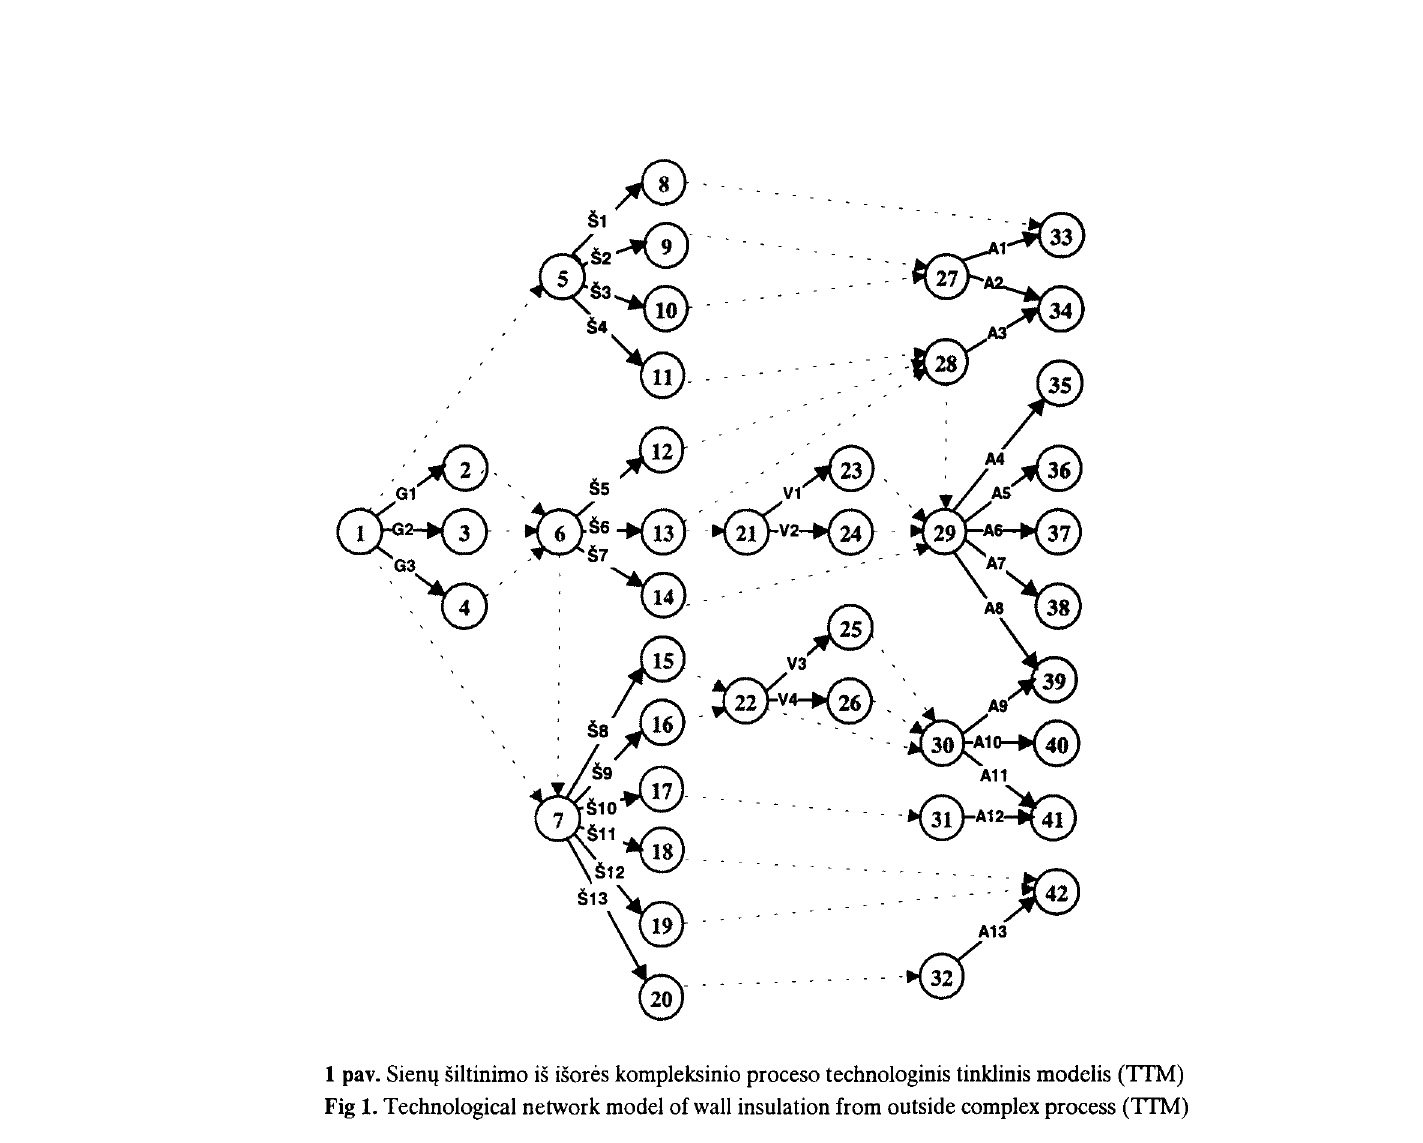
Fig 1. Technological network model of wall insulation from outside complex process (TIM) TaCiau optimizuojant sprendimus tikslinga analizuoti tarpiniq sprendimq efektyvumq ir jq itakq galutiniam rezultatui. Todel autorius siiilo taikyti technologinio tinklinio modelio mazgq "ispjovimo"